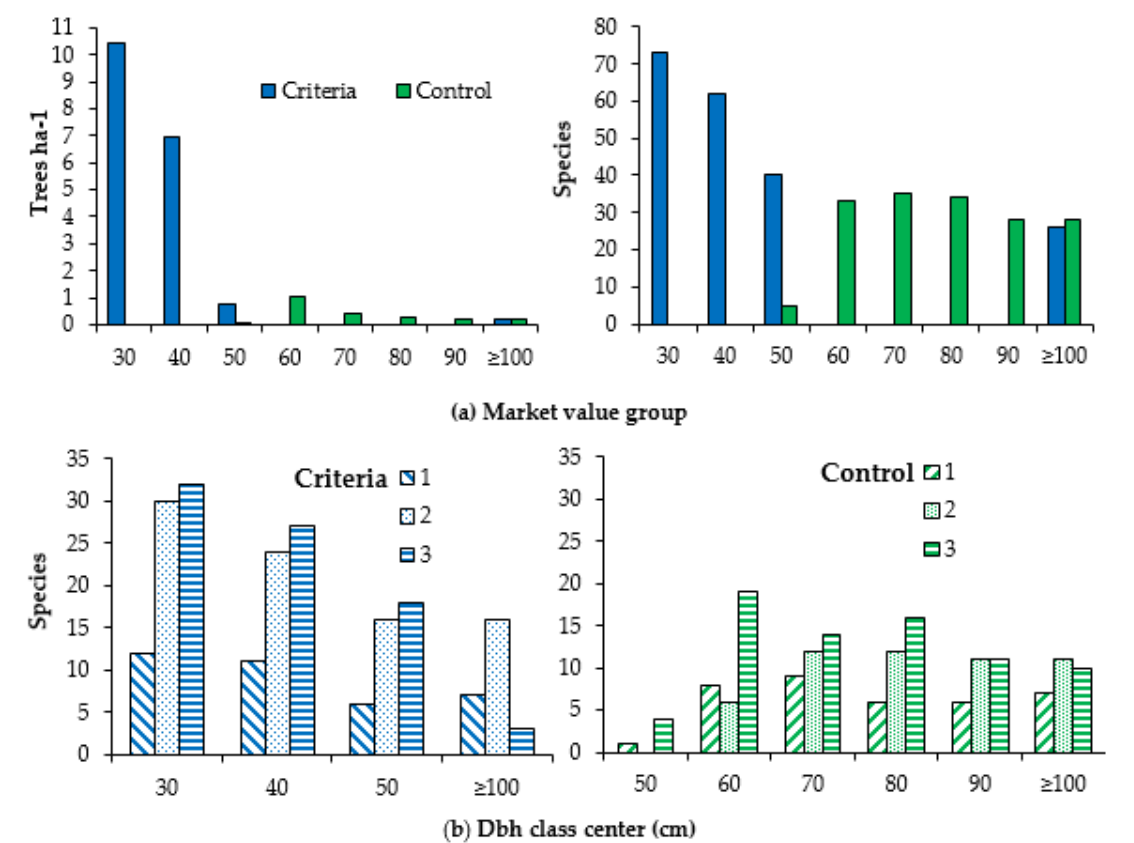
Diversity 2021 , 13 , x FOR PEER REVIEW 10 of 16 Figure 3. Trees and species destined for the sale of standing wood by the market value group ( a ) and dbh class center ( b ) for the criteria and control treatments, forest management area of Fazenda Shet, Dom Eliseu, State of Pará, Brazil.